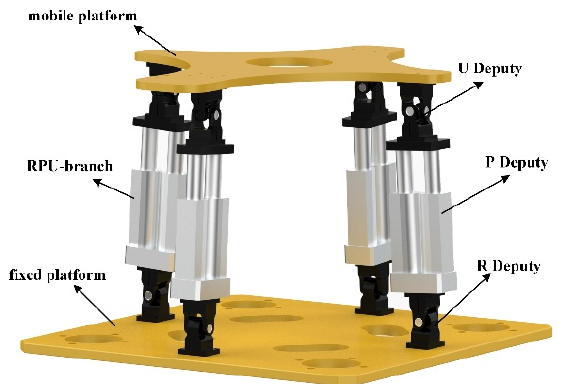
Figure 2. 4-RPU parallel mechanism.